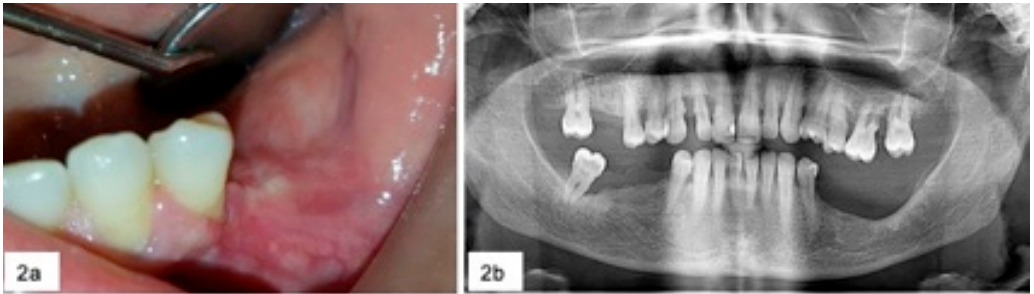
Figure 2. Clinical ( a ) and radiological ( b ) follow-up of the patient after 18 months.